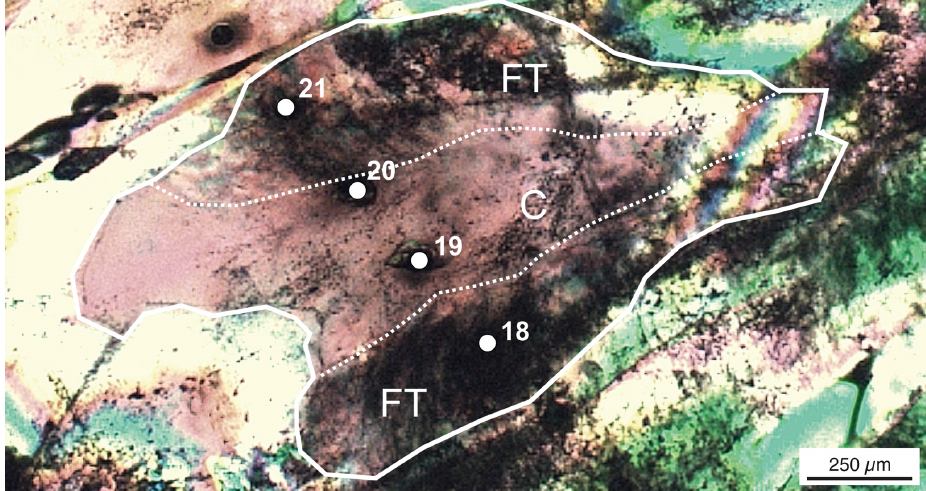
Figure 8. Detail of a single quartz grain exhibiting a clear quartz core without feathery textures (C) surrounded by feathery textures (FT). Both areas were analyzed using LA-ICP-MS in order to directly compare quartz composition on a single grain. A solid white line outlines the quartz grain, while the dotted white lines delimit core and feathery texture sections. Spots 18 and 21 completely hit feathery textures, spots 19 and 20 affected feathery texture-free quartz only. Anomalous quartz interference colors are due to the fact that the fluid wafer has a thickness of about 200µm. Oriented sample TY39X1, X pol.